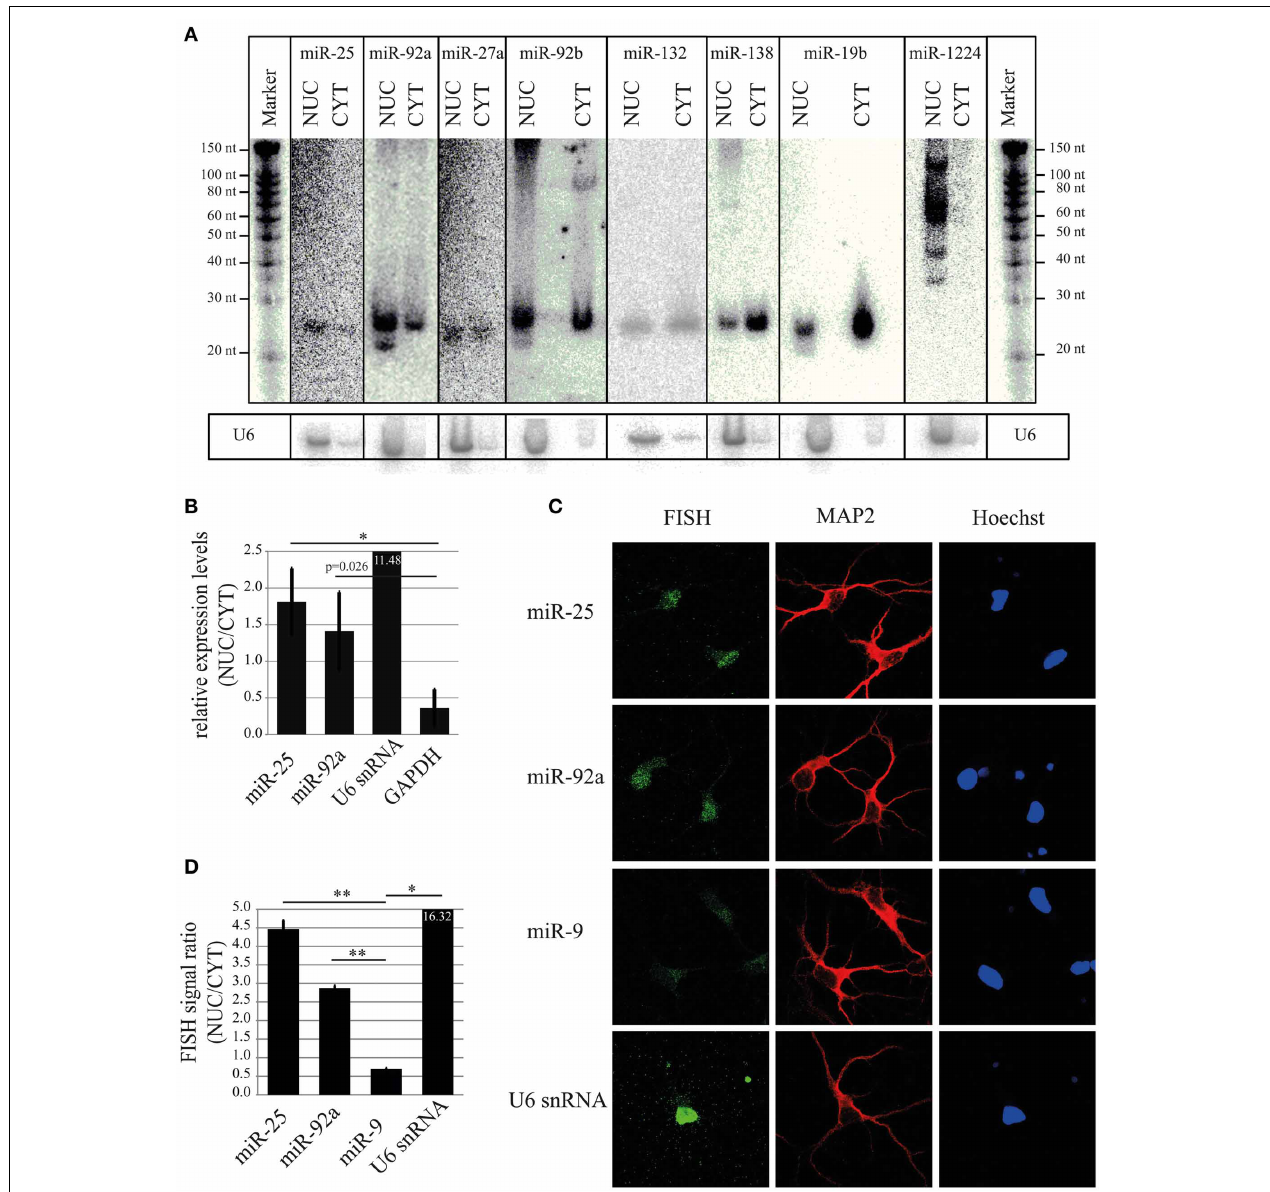
FIGURE 5 | Validation of nuclear expression for selected miRNA candidates. (A) Northern blot analysis of nuclear-enriched (miR-25, miR-92a, miR-27a, miR-92b) and -depleted miRNAs (miR-138, miR-19b). As a control for the fractionation efficacy, U6 snRNA was probed. (B) qRT-PCR analysis of nuclear-enriched miRNAs (miR-25 and miR-92a). The fold enrichment (y-axis) of miRNAs and marker genes (U6 snRNA and GAPDH) in the nucleus was calculated by the 2 − dCt [2 − ( NUC Ct − CYT Ct ) ] method. Bar plots show mean ± SD ( n = 3). Statistical significance was determined using Student’s t -test with Bonferroni correction ( ∗ p < 0 . 05). (C) Subcellular localization of the indicated miRNAs at DIV5 hippocampal neurons as assessed by fluorescent